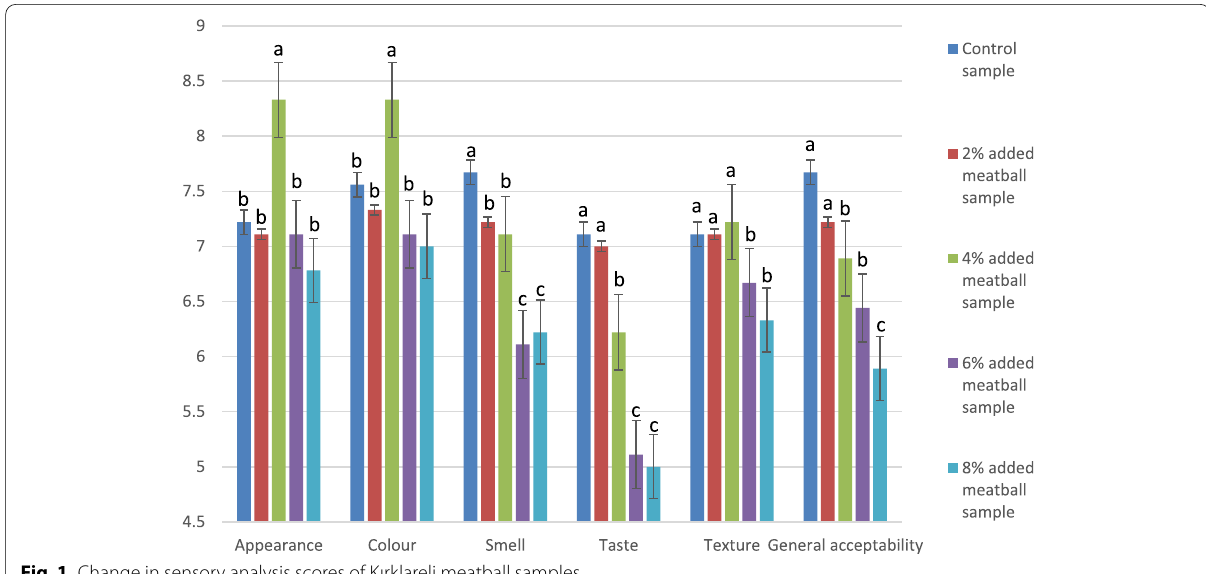
Fig. 1 Change in sensory analysis scores of Kırklareli meatball samples Scores are presented on a 1–9 scale with 1 being bad and 9 being very good. Differences between means with a different letters exceed the estimate of least significant difference at 5% critical value. Comparisons were made on an individual trait basis and are applicable across infusion treatments within each trait (apparance, colour, smell, taste, texture and general